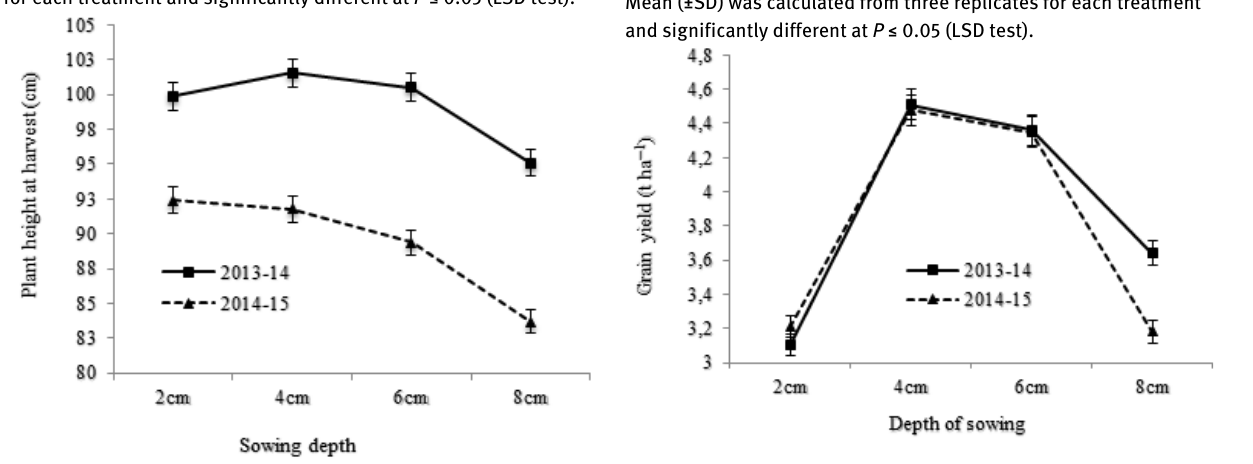
Figure 10 : Grain yield of wheat as affected by sowing depth. Mean (±SD) was calculated from three replicates for each treatment and significantly different at P ≤ 0.05 (LSD